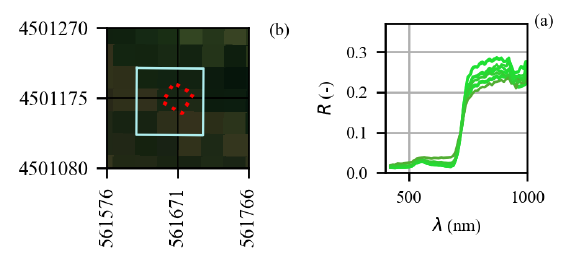
Figure 1 . DESIS 3-by-3 window over a FunDivEUROPE site.